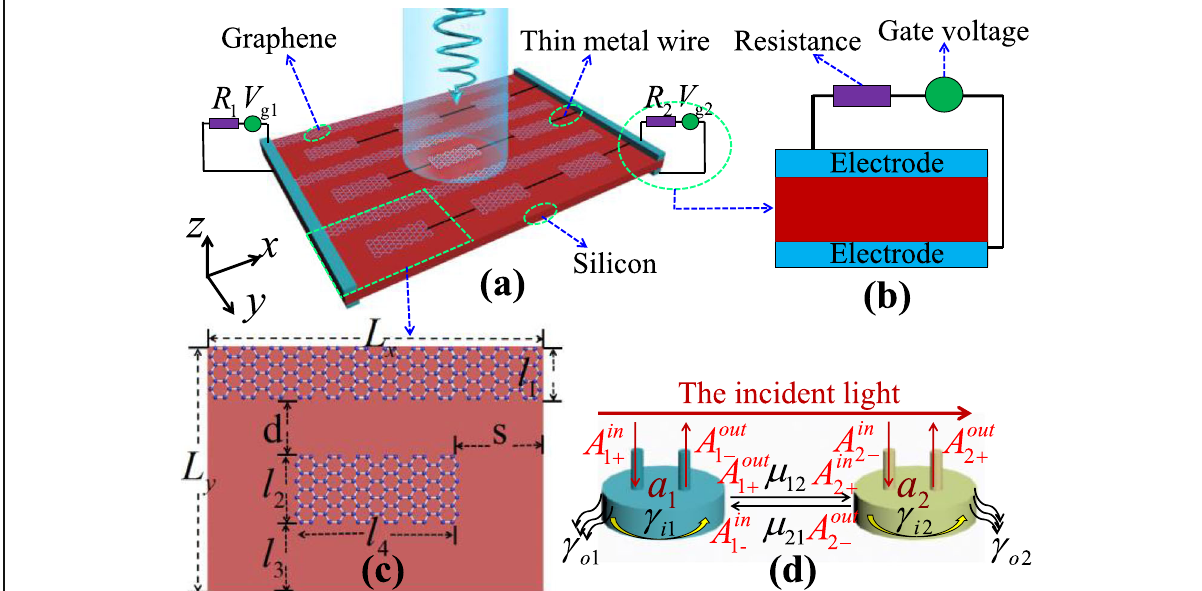
Fig. 1 a Schematic of the 3 × 3 unit structure of the PIT metasurface. b The modulated diagram of gate voltage. c Top view of structural unit with geometric parameters L x = 6.0 μ m, L y = 4.0 μ m, l 1 = 1.0 μ m, l 2 = 1.4 μ m, l 3 = d = 0.8 μ m, l 4 = 2.9 μ m, and S = 1.55 μ m. d Coupling diagram between the graphene ribbon and the graphene